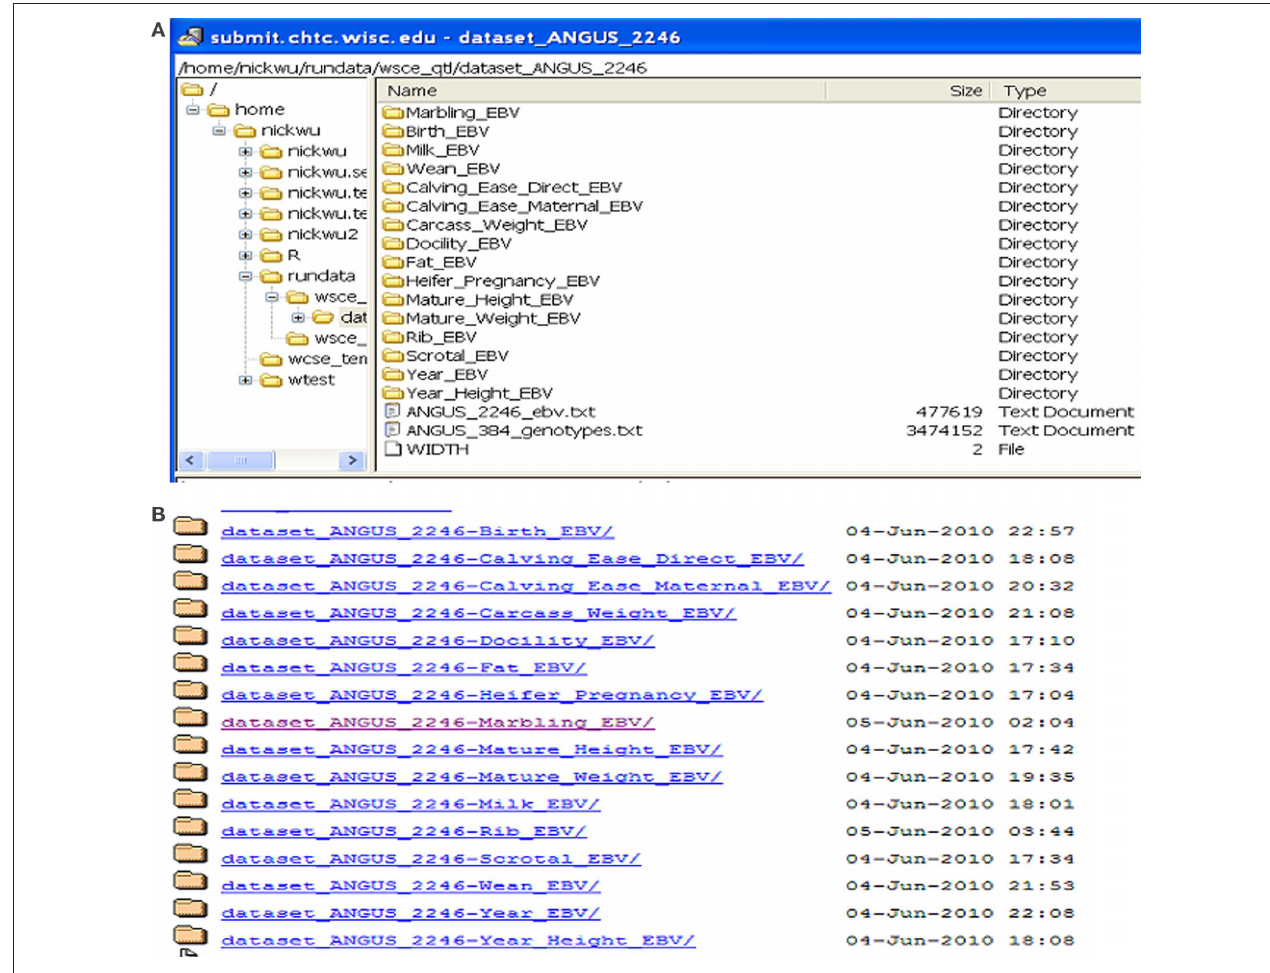
FiGure 7 | results stored on the submit machine (A) and also deployed in web-accessible folders